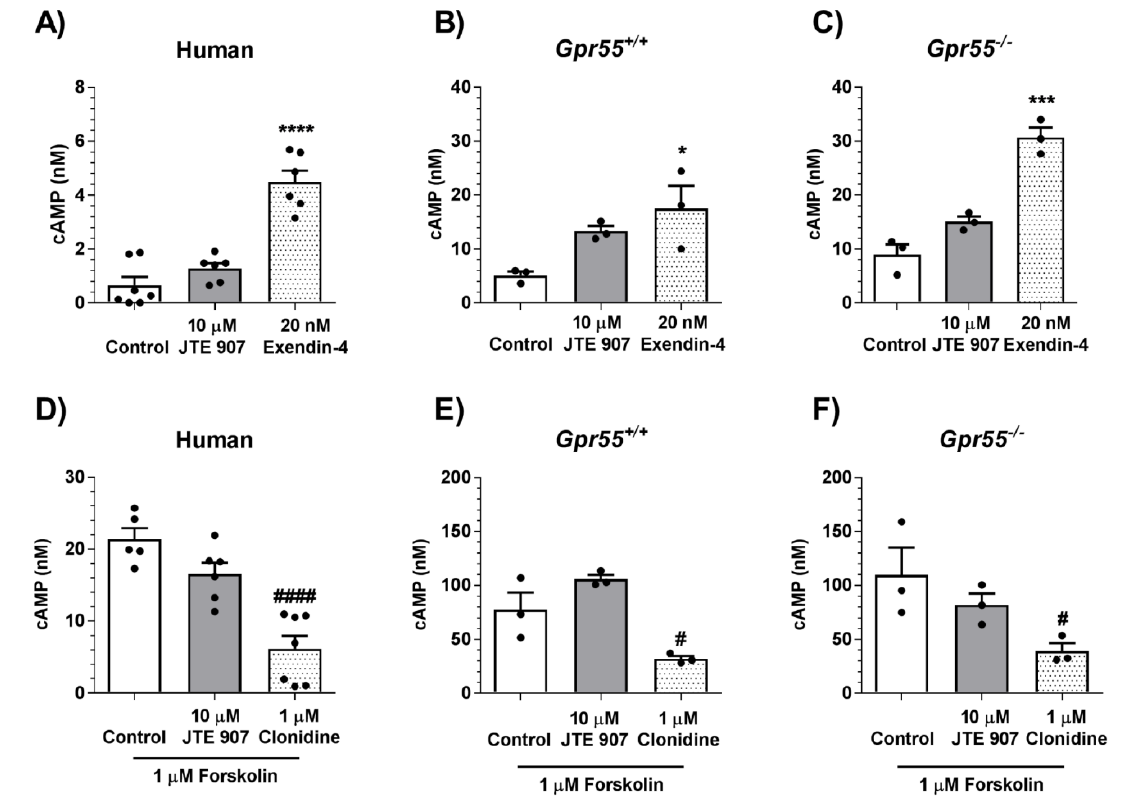
Figure 5. Effects of JTE 907 on cAMP levels in human and mouse islets. 10 µ M JTE 907 had no effect on cAMP accumulation in untreated human islets ( A ) or those exposed to 1 µ M forskolin ( D ). JTE 907 also did not significantly affect cAMP levels in islets isolated from Gpr55 +/+ ( B , E ) and Gpr55 − / − ( C , F ) mice ( p > 0.05 for all JTE 907 vs. control comparisons). In the same experiments, 20 nM exendin-4 and 1 µ M clonidine significantly increased and decreased cAMP, respectively ( A – F ). Data show mean + SEM data of 3–6 observations per treatment group that are representative of 3 independent experiments using both mouse and human islets. * p < 0.05, *** p < 0.001, and **** p < 0.0001 exendin-4 vs. basal; # p < 0.05 and #### p < 0.0001 clonidine vs. forskolin. Data were analysed using one-way ANOVA, followed by Dunnett’s multiple comparisons post-test.